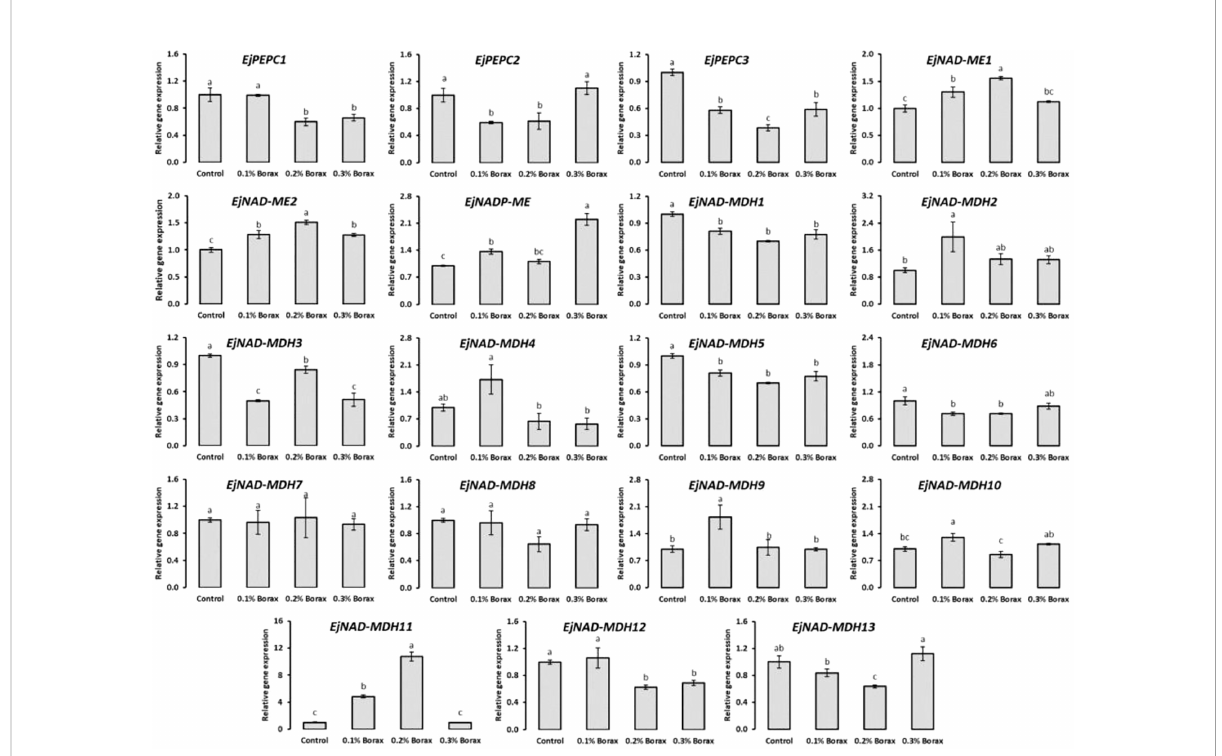
FIGURE 8 The expression pro fi ling of core genes involved in malic acid metabolism of loquat as in fl uenced by the foliar application of B. Same letters indicate non-signi fi cant difference among treatments according to Fisher ’ s least signi fi cant difference (LSD) test, when p ≤ 0.05 . Vertical bars indicate mean ± standard error (4 biological and 3 technical